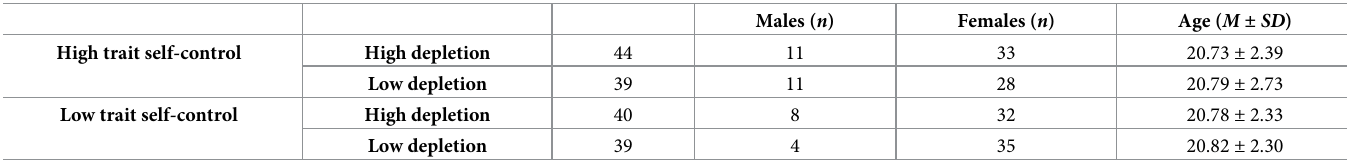
Table 1. Number of males and females and age characteristics of the four